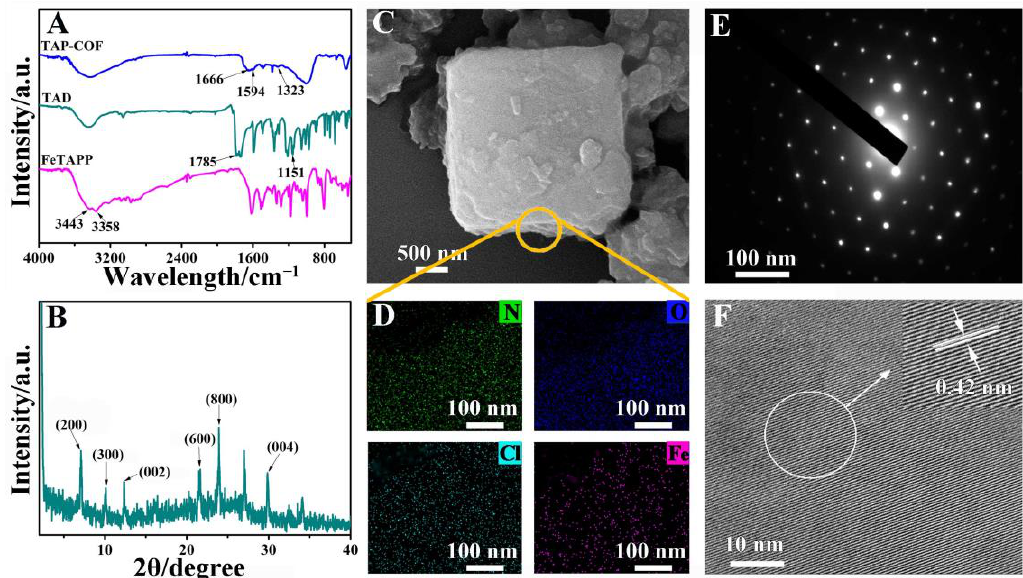
Scheme 1. Diagrammatic drawing for the synthesis of TAP-COF and in situ detection of H 2 O 2 re- leased from MCF-7 cells.